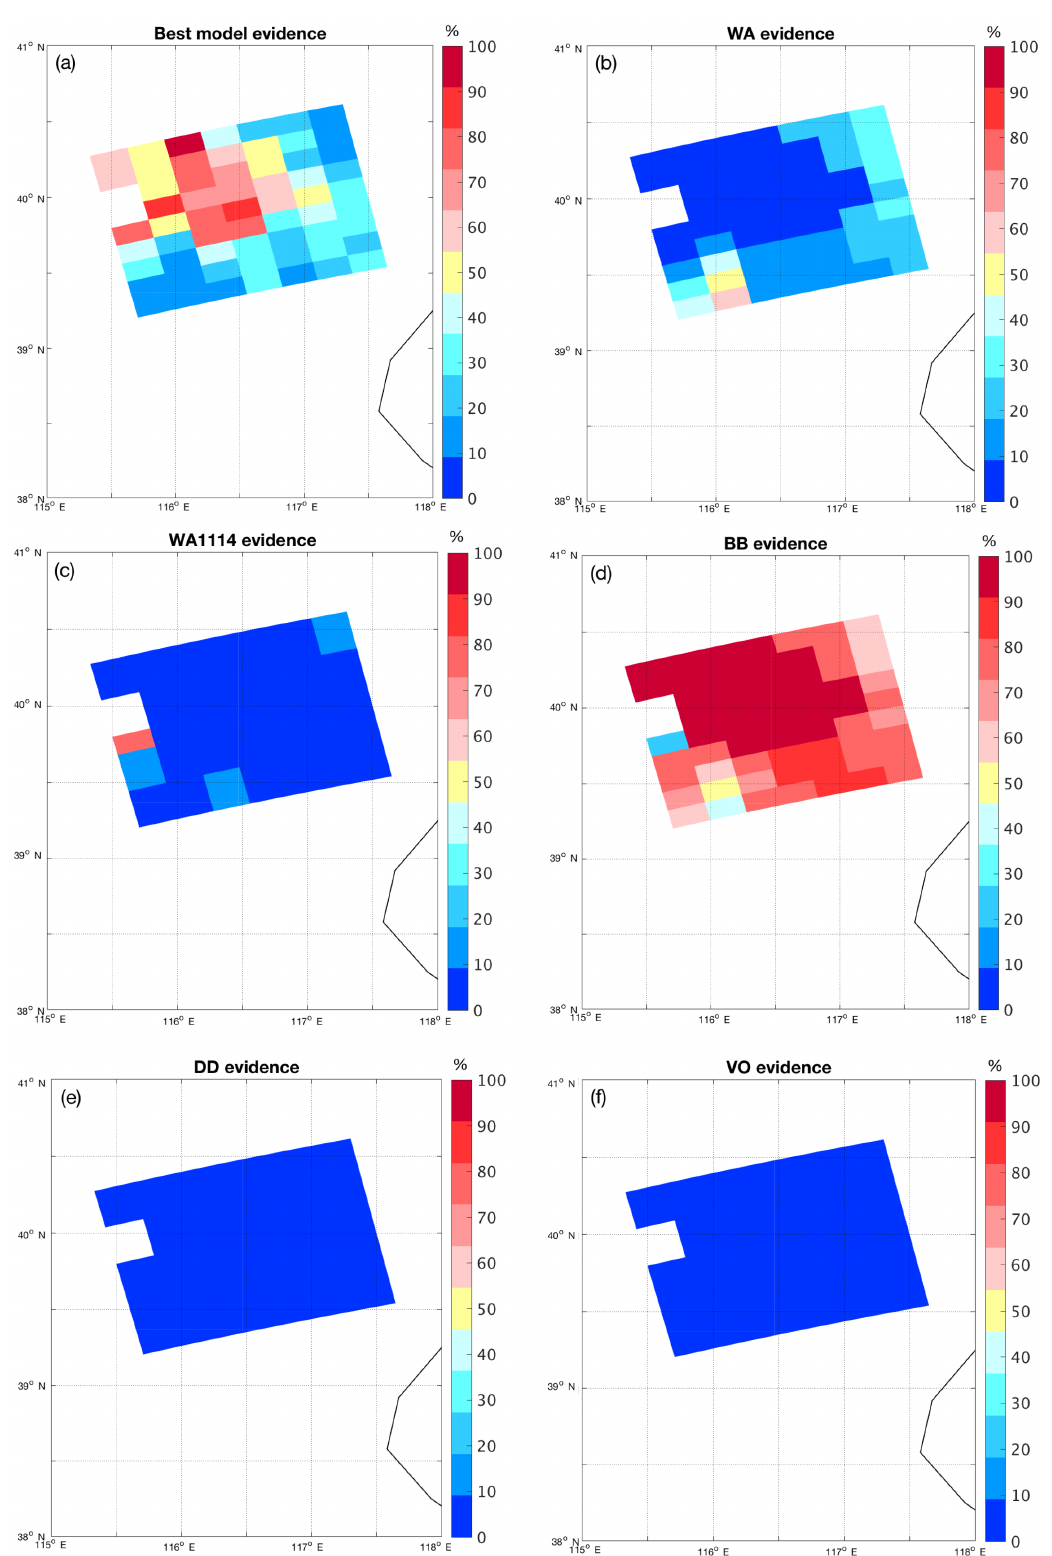
Figure 4. The relative evidence distribution (%) of the selected models on 16 April 2008. (a) The relative evidence of the best model with the highest amount of evidence and the shared evidence of the best models within each main aerosol type: (b) weakly absorbing, (c) weakly absorbing sea salt, (d) biomass burning, (e) desert dust and (f) volcanic